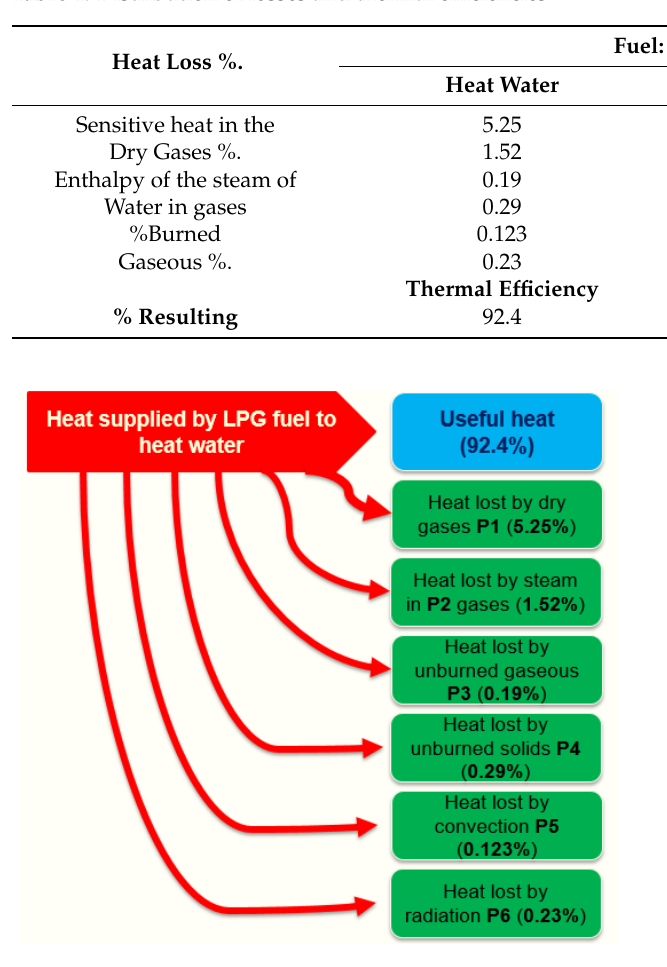
Figure 6. Sankey diagram: distribution of losses for heating water.